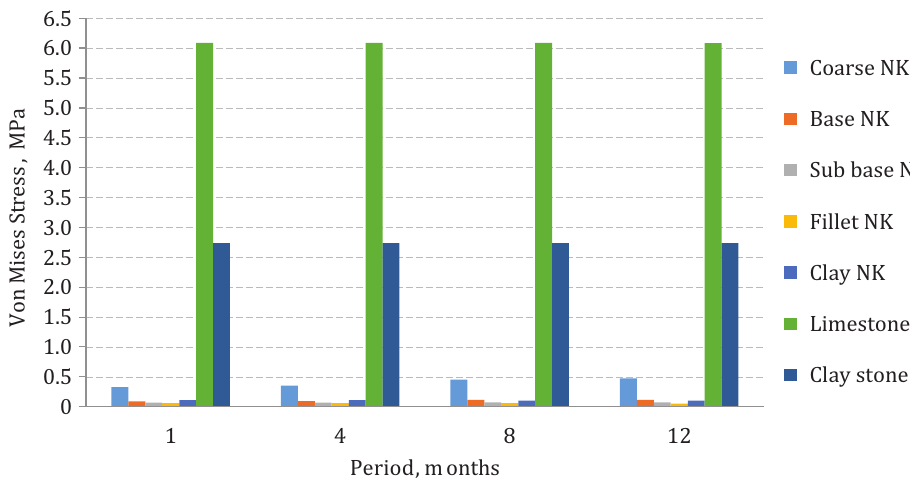
Figure 10. Von Mises stress-time changes of the layers for NK-Type